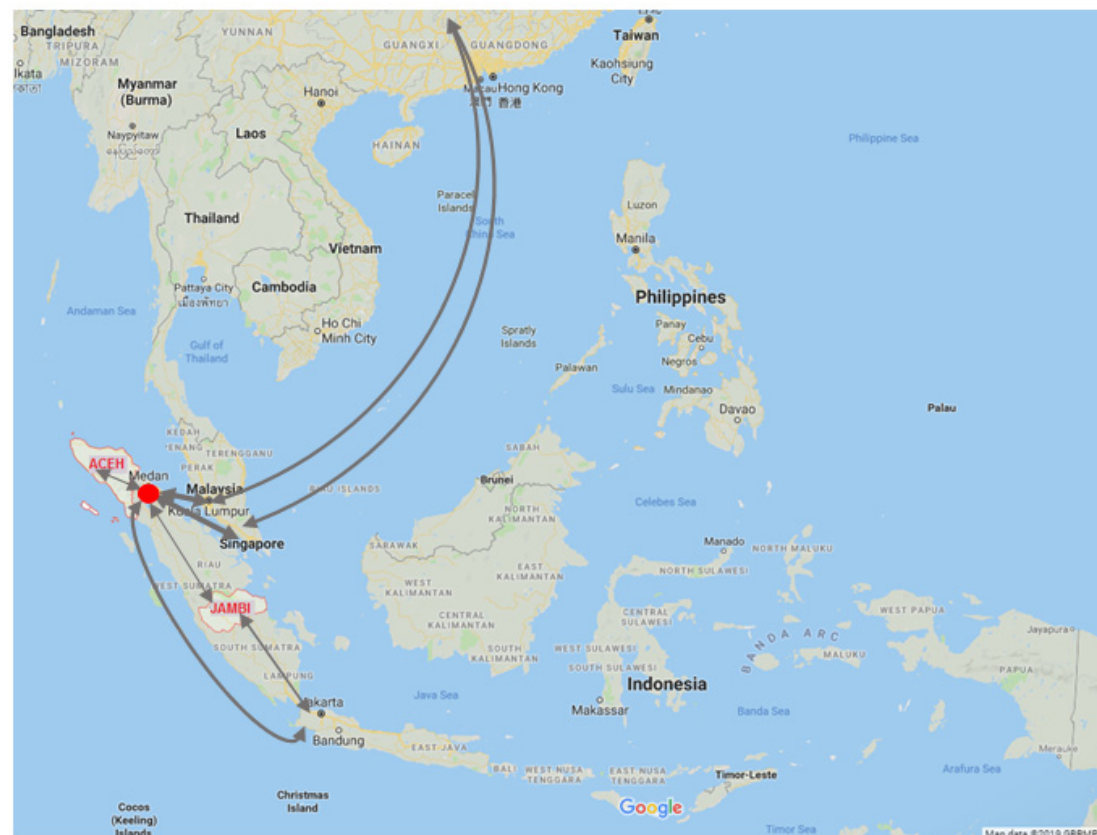
Figure 6. Flight patterns between Aceh and Jambi. The arrows indicate the main flight routes between Aceh, Jambi and neighbor localities. Red dot indicates location of Medan, the capital of North Sumatra Province. Medan is the largest city in Sumatra Island and has major international flight routes connected to neighboring dengue endemic areas, especially Malaysia and Singapore. There is no direct flight between Aceh and Jambi